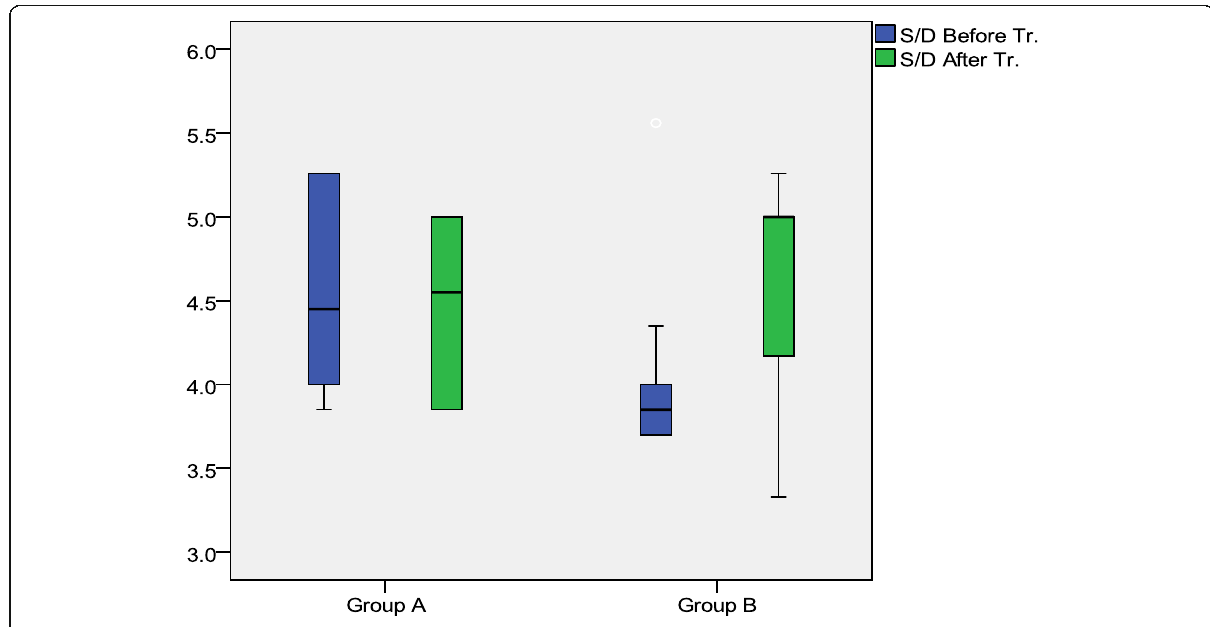
Fig. 6 Middle cerebral artery S /: D ratio before and after treatment in both